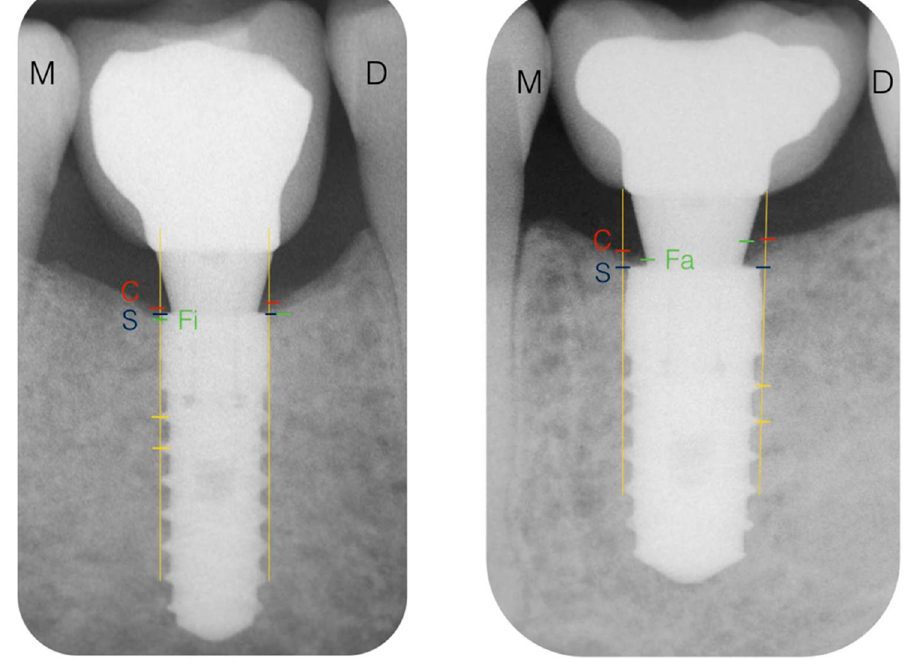
Figure 1. Reference landmarks in the X-rays. C, bone crest; S, implant shoulder; Fi, first bone–implant contact; M, mesial; D, distal; S–C distance, marginal bone level at the crest (MBLc); S–Fi distance, marginal bone level at the implant (MBLi); S–Fa distance, marginal bone level at the abutment (MBLa).